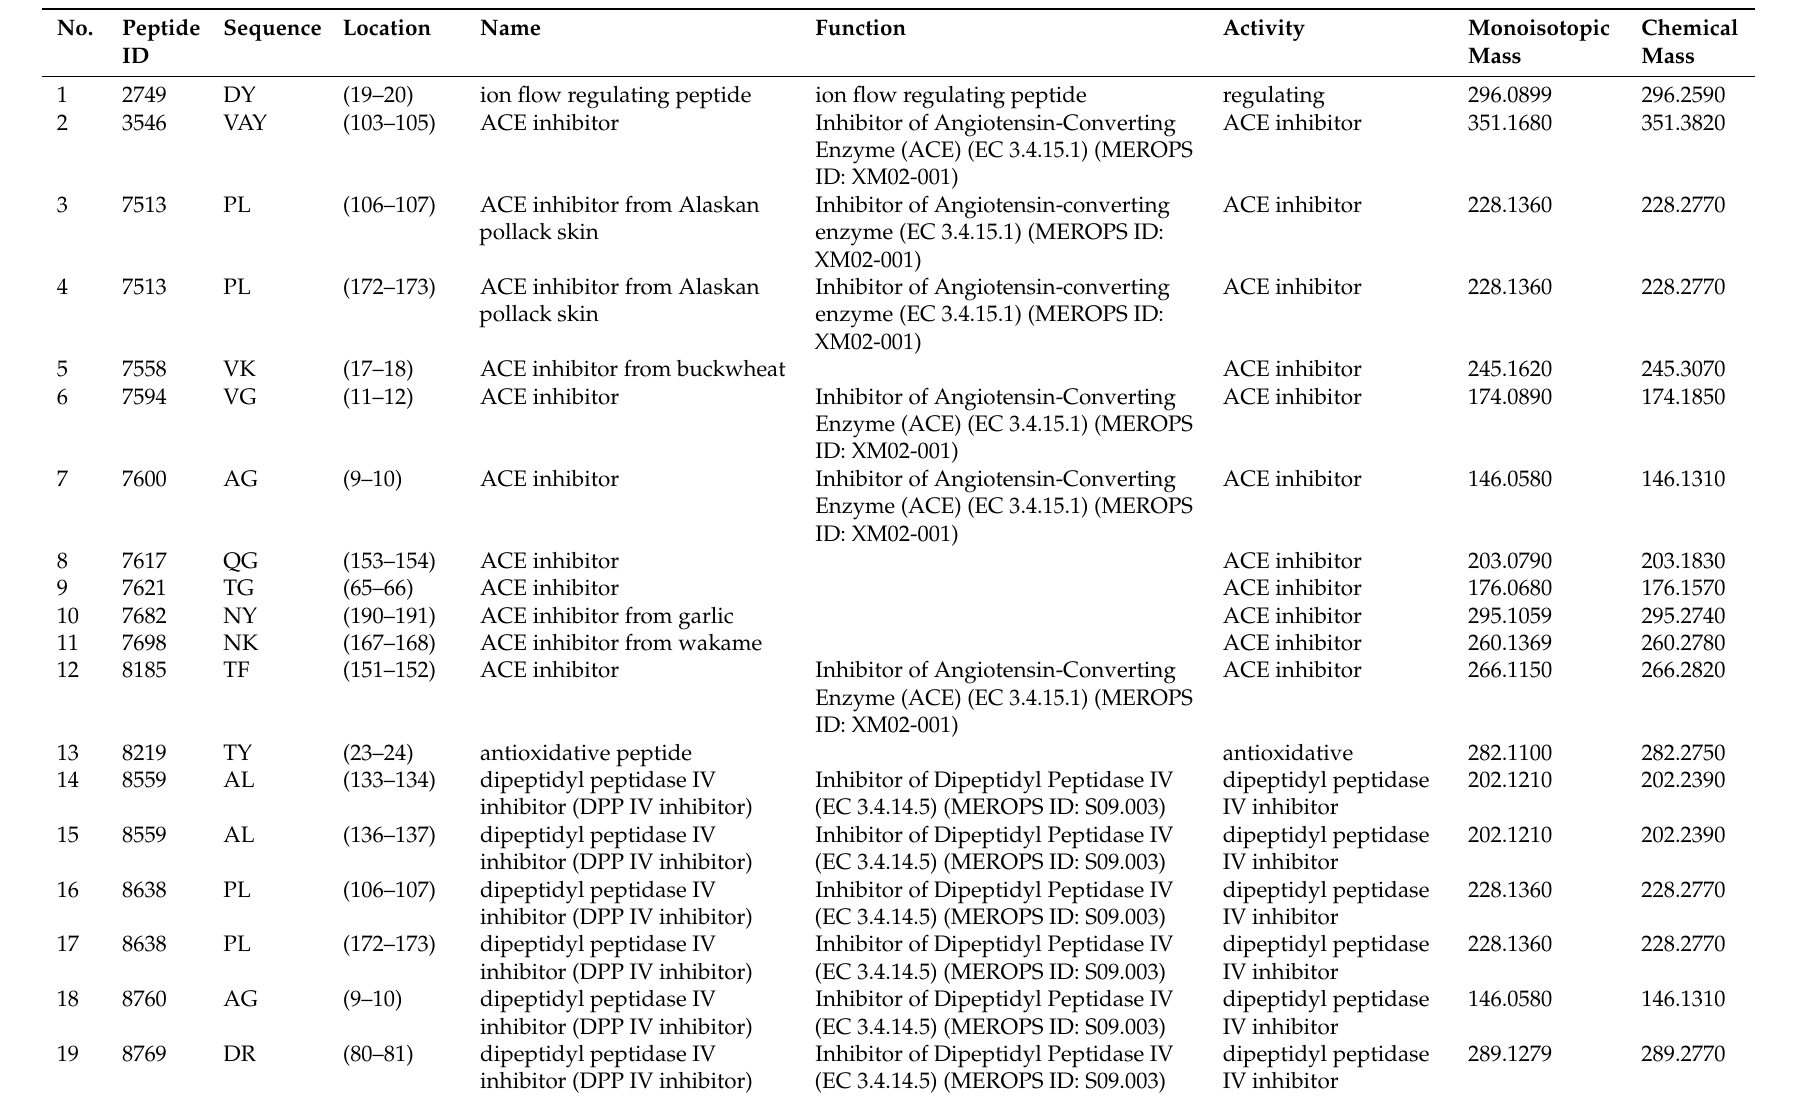
Table A29. Bioactive peptides from RubisCO of Halophila stipulacea . In silico enzymatic cleavage was carried out by using